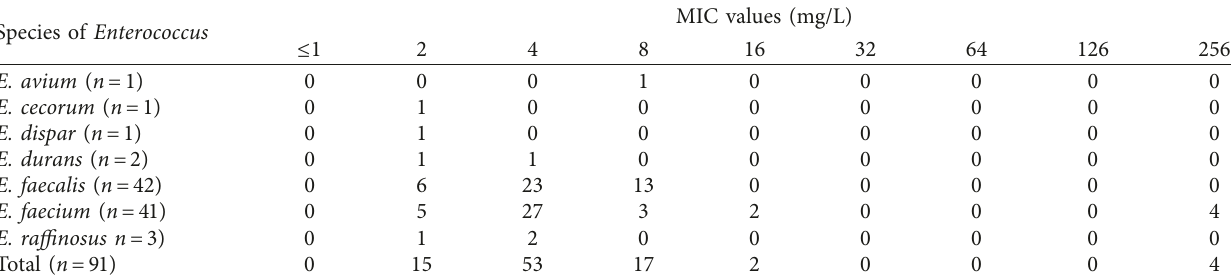
Table 4: MIC value of vancomycin ( μ g/ml) in different clinical